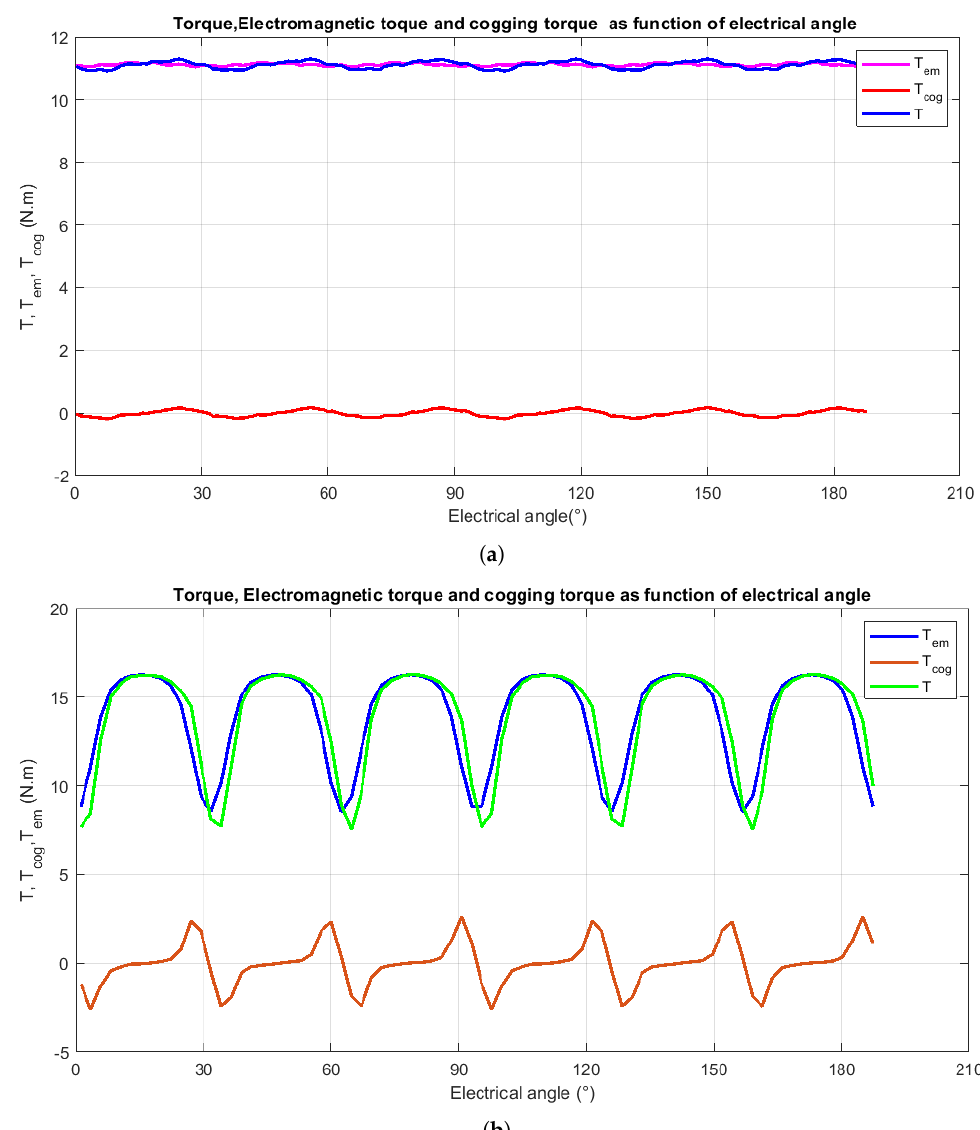
Figure 11. Torque, electromagnetic toque and cogging torque for HAPMS ( a ) and MMS ( b ) as a function of electrical